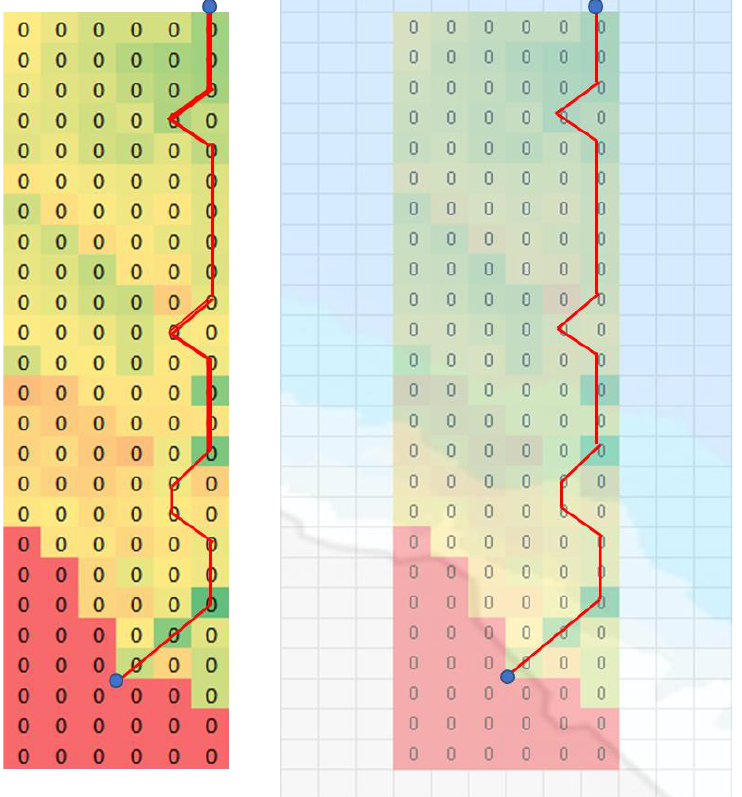
Figure 4. Cable route between Ribadeo floating wind farm and the shoreline after methodology application. Grid model showing the coastal area ( right ) and numerical model of grid ( left ). 0 means coastal area; 1 means area to be considered.